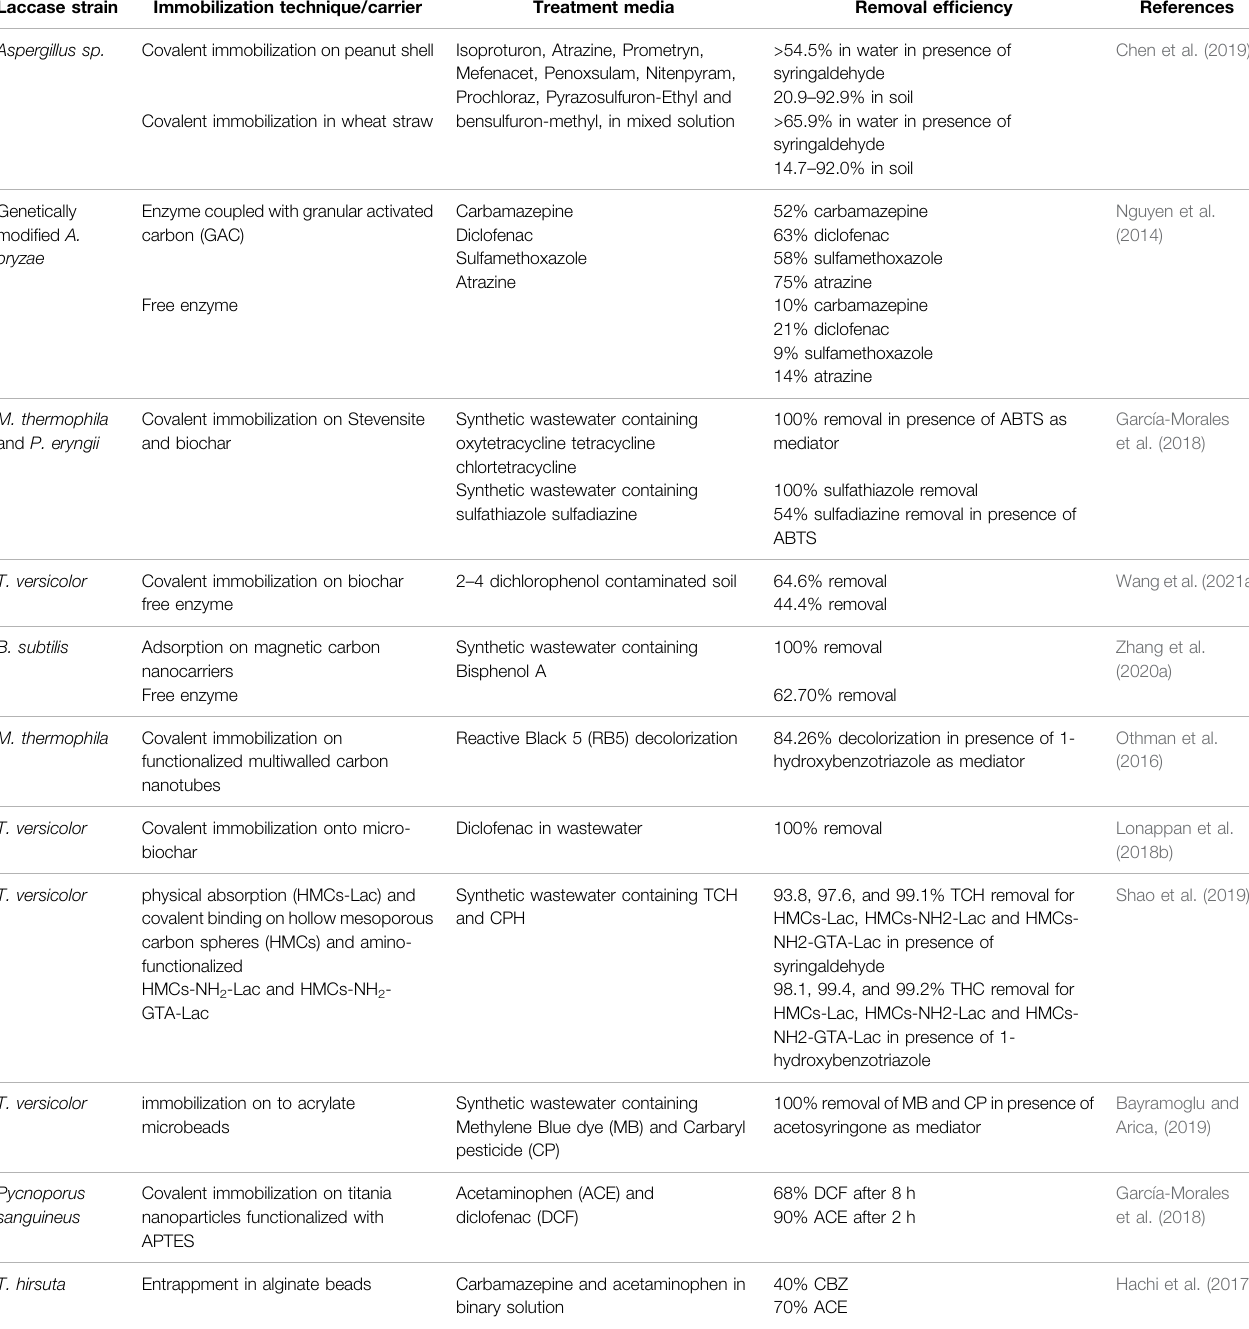
TABLE 7 | Removal of trace organic contaminants by immobilized laccase. Laccase